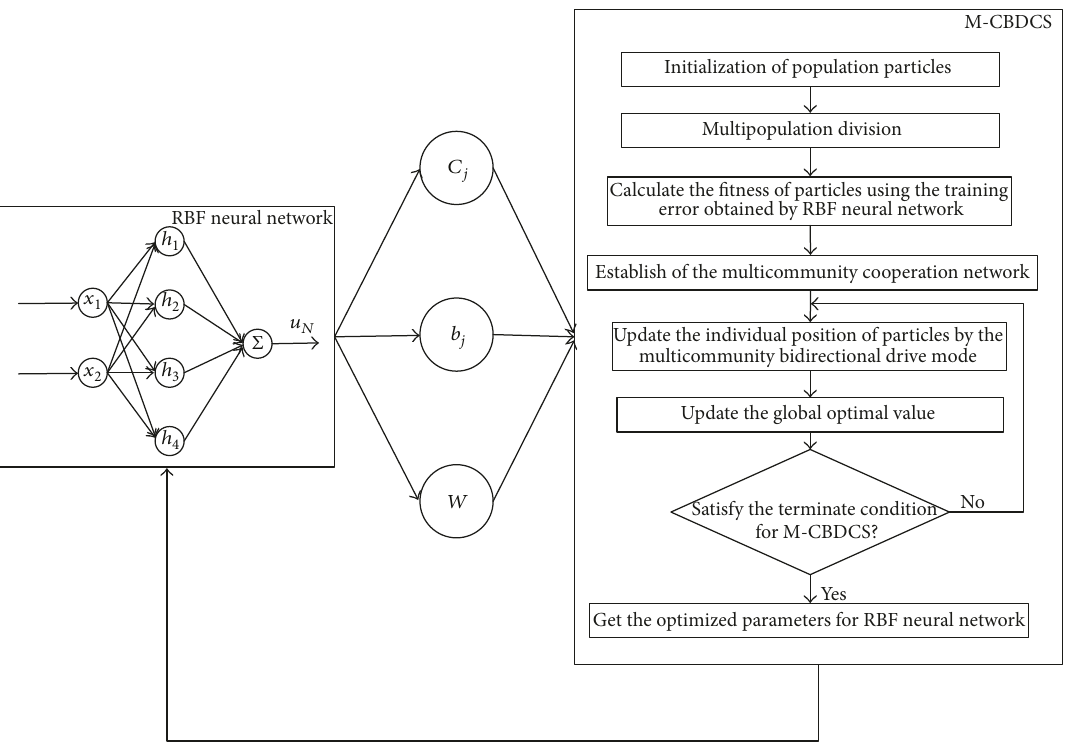
Figure 3: The flow diagram about the adaptive RBF neural network with